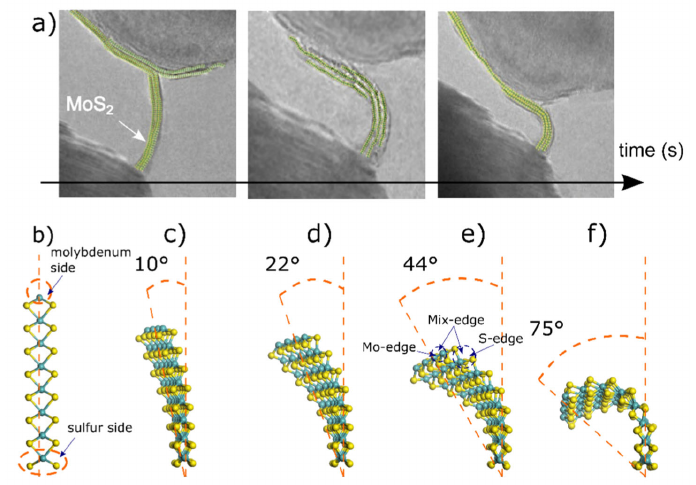
Figure 1. ( a ) Color ‐ coded experimental observations made by in ‐ situ HRTEM technique showing the induced bending curvature for 2H ‐ MoS 2 layers, adapted from Casillas et al., J. Phys. Chem. C 2015, 119, 710 − 715. Ref. [22] under rights and permissions of ACS copyrights©. ( b – f ) Molecular models for 2H ‐ MoS 2 are used for HOMO ‐ LUMO calculations; the main bending angles go from 0° to 75°. Cyan balls are molybdenum atoms and yellow balls are sulfur atoms. Mo side refers to the upper part of the slab composed of fourfold molybdenum ions. S ‐ edge refers to the bottom part of the slab which ends in sulfur ions with twofold coordination.